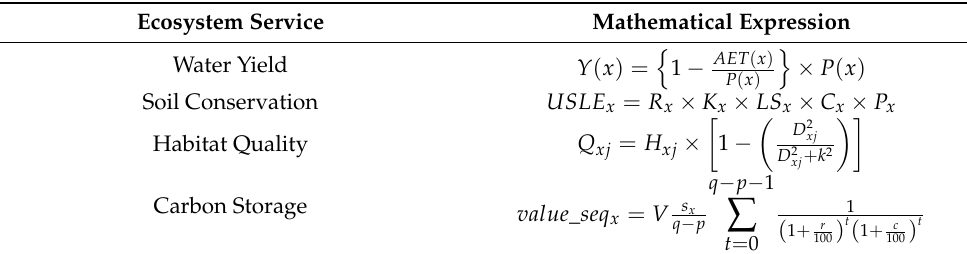
Table 1. Methods for quantifying ecosystem